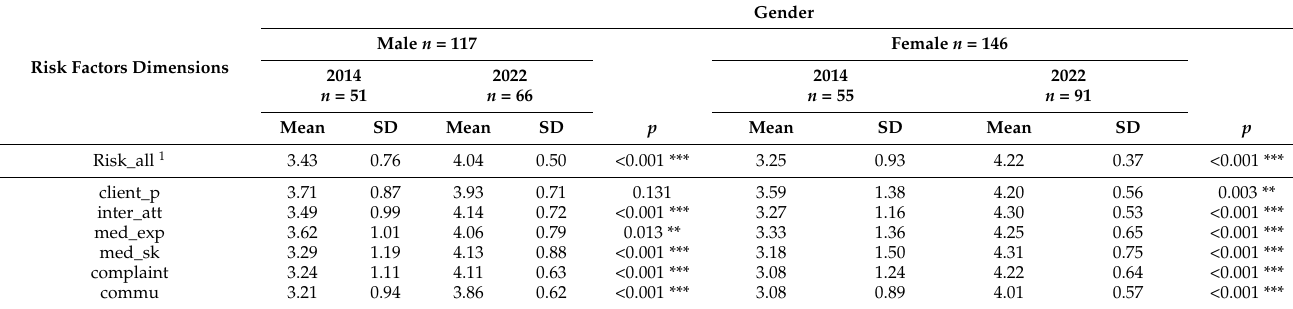
Table 8. Comparisons of the risk factor perceptions differences between 2014 and 2022 for gender subgroups.